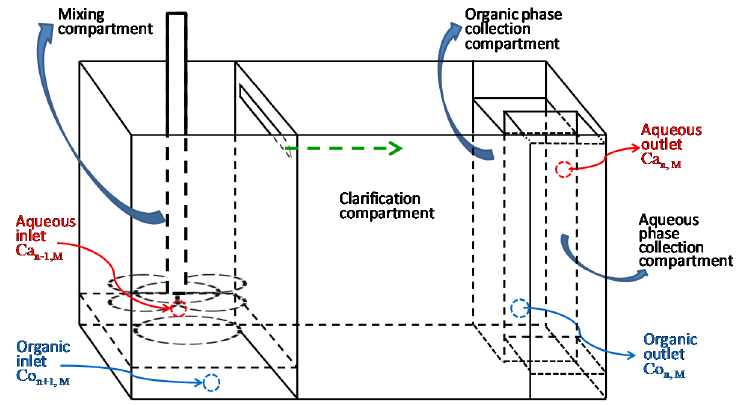
Figure 2. Structure of the bench scale self-made mixing–clarification extraction tank.